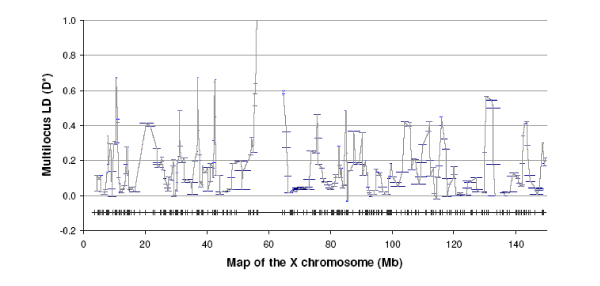
Multilocus LD of the X chromosome. Bars represent sliding windows of 5 markers each, whose D* value is plotted. The line under the chart shows the marker location; a large gap centered at 60 Mb may be noted.